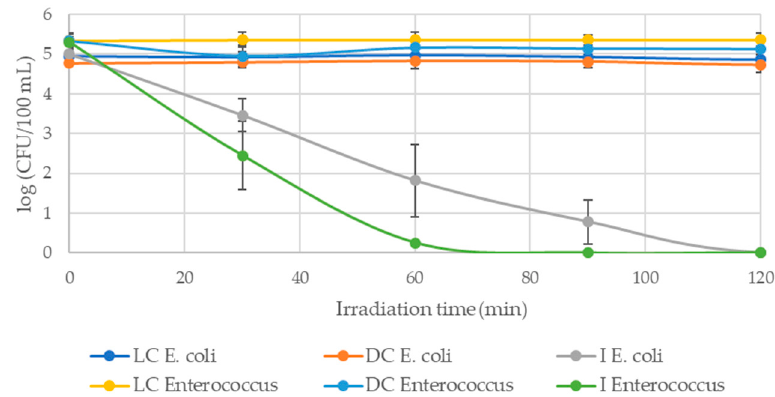
Figure 5. E. coli and Enterococcus inactivation in WW without addition of bacteria. Tetra-Py + -Me was used at a concentration of 10 µM and the samples were irradiated with artificial PAR white light (380–700 nm) with an irradiance of 40 W m − 2 for 120 min. Legend: light control (LC), dark control (DC), and irradiated samples (I). Values represent the mean of three independent experiments with two replicates each.